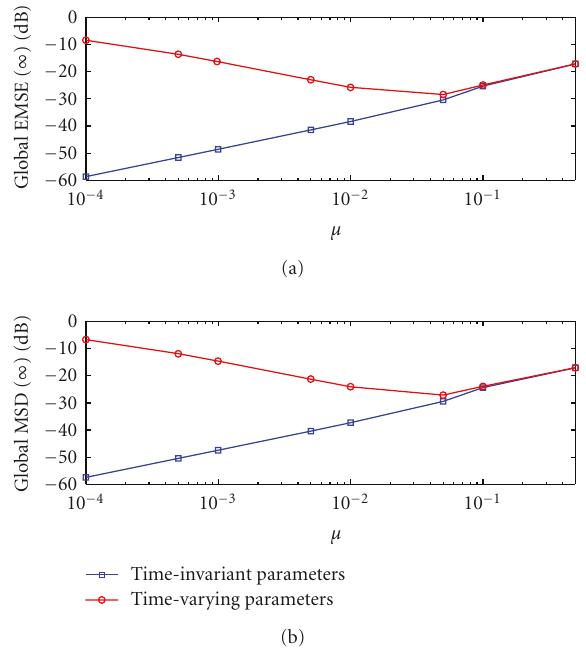
Figure 6: Global s.s. EMSE and MSD versus step-size dependencies.